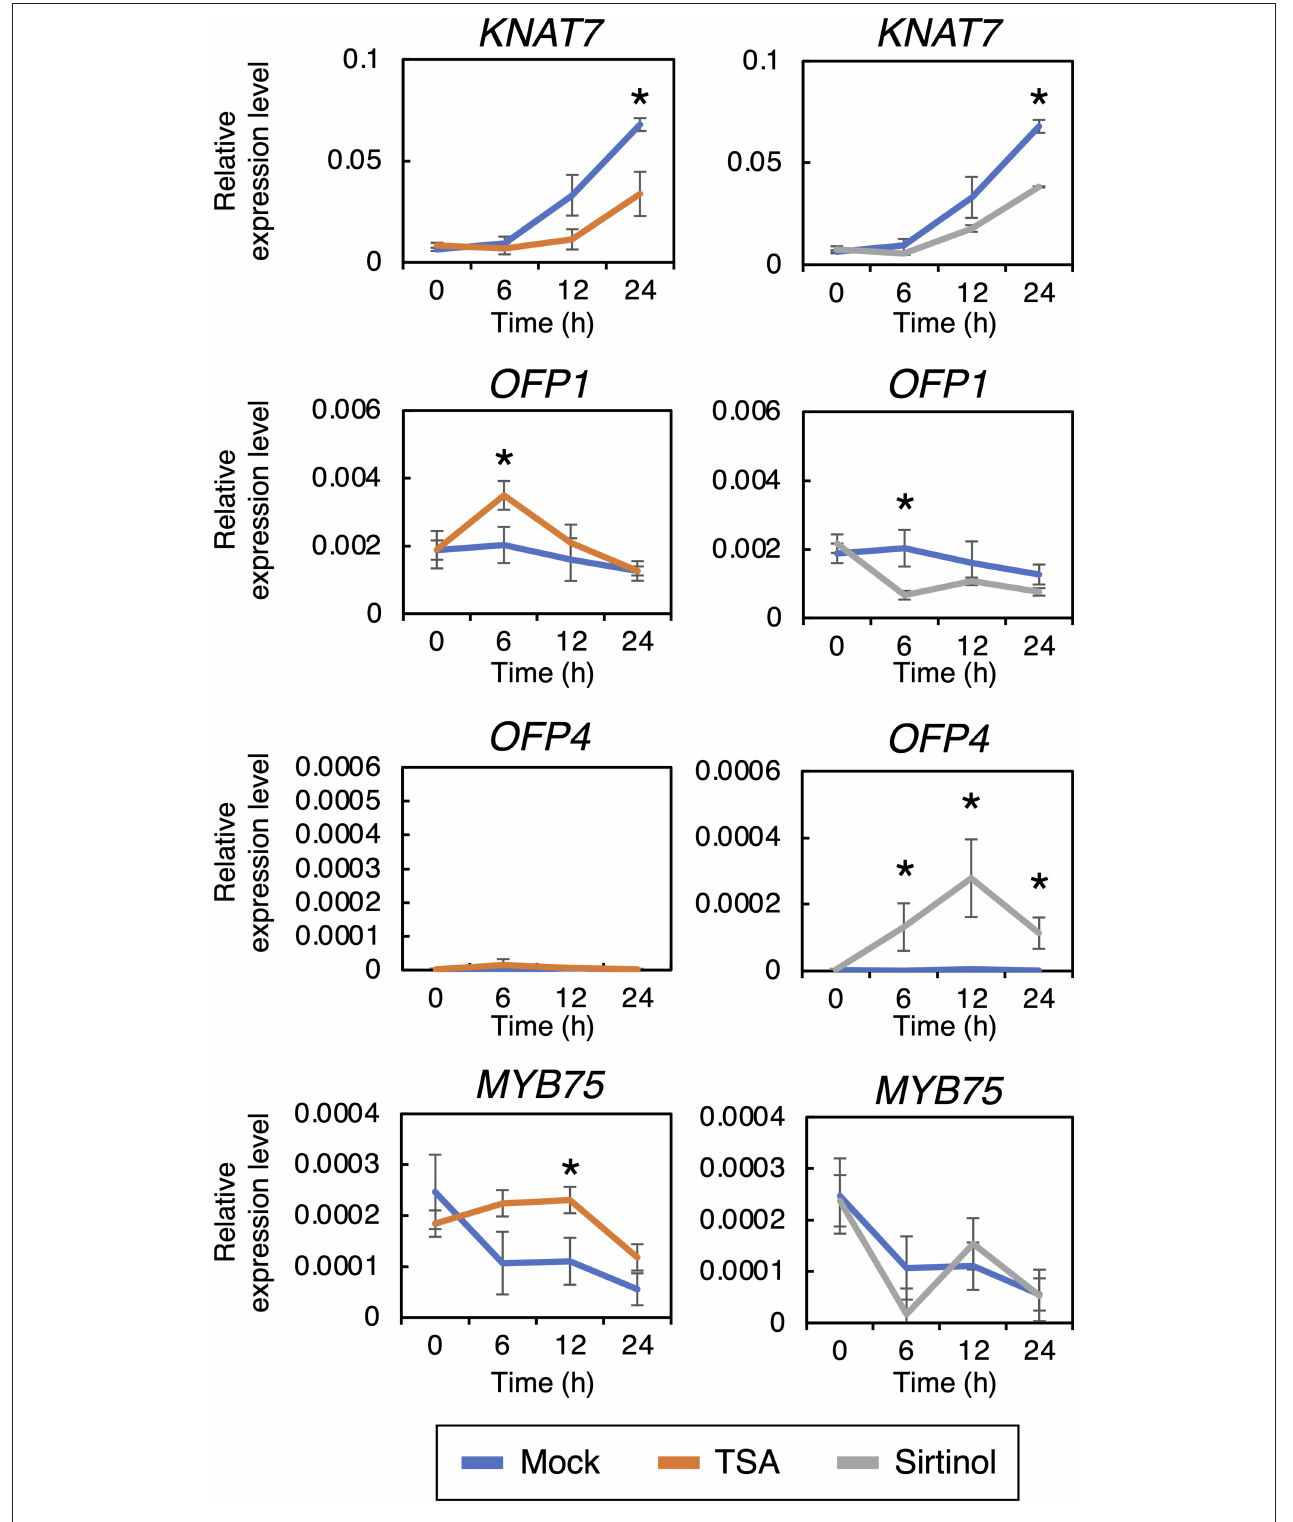
FIGURE 5 | Reverse transcription quantitative PCR analysis of genes encoding transcription factors known to negatively regulate xylem vessel cell differentiation. Seven-day-old VND7–VP16–GR seedlings were treated with 10nM dexamethasone (DEX) and 5 µ M trichostatin A TSA or 10 µ M sirtinol and sampled after 0, 6, 12, 18, and 24h. The transcript levels of the genes downstream of VND7 were quantified by reverse transcription quantitative PCR and normalized to the expression level of the internal control UBIQUITIN10 . Results are shown as means ± SD ( n = 3). Asterisks indicate statistically significant differences compared with the mock control (Student’s t -test, p <